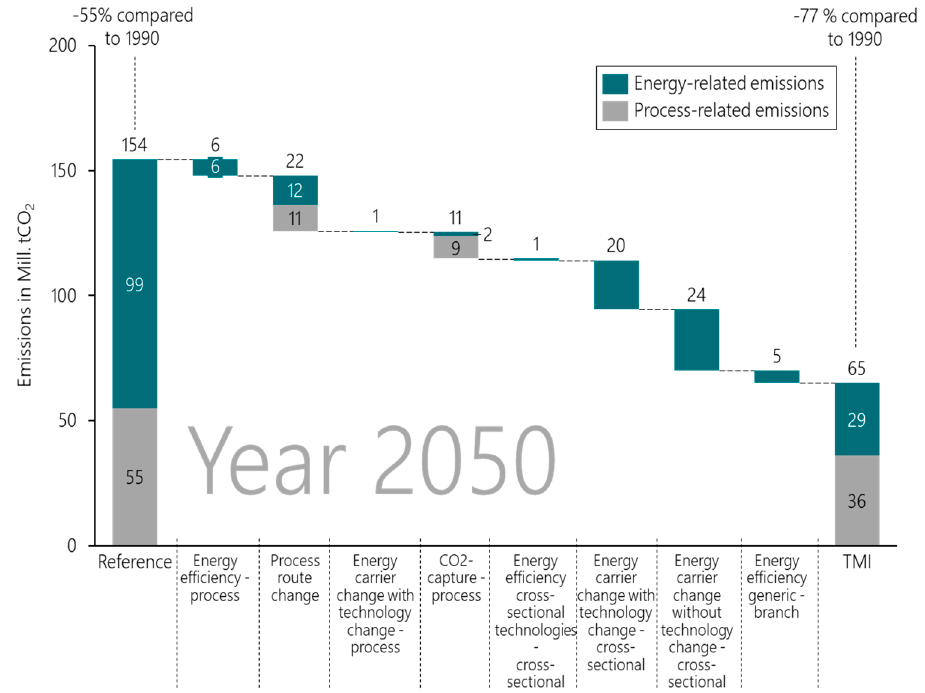
Figure 9. Emission difference between reference and TMI scenario according to category in 2050.